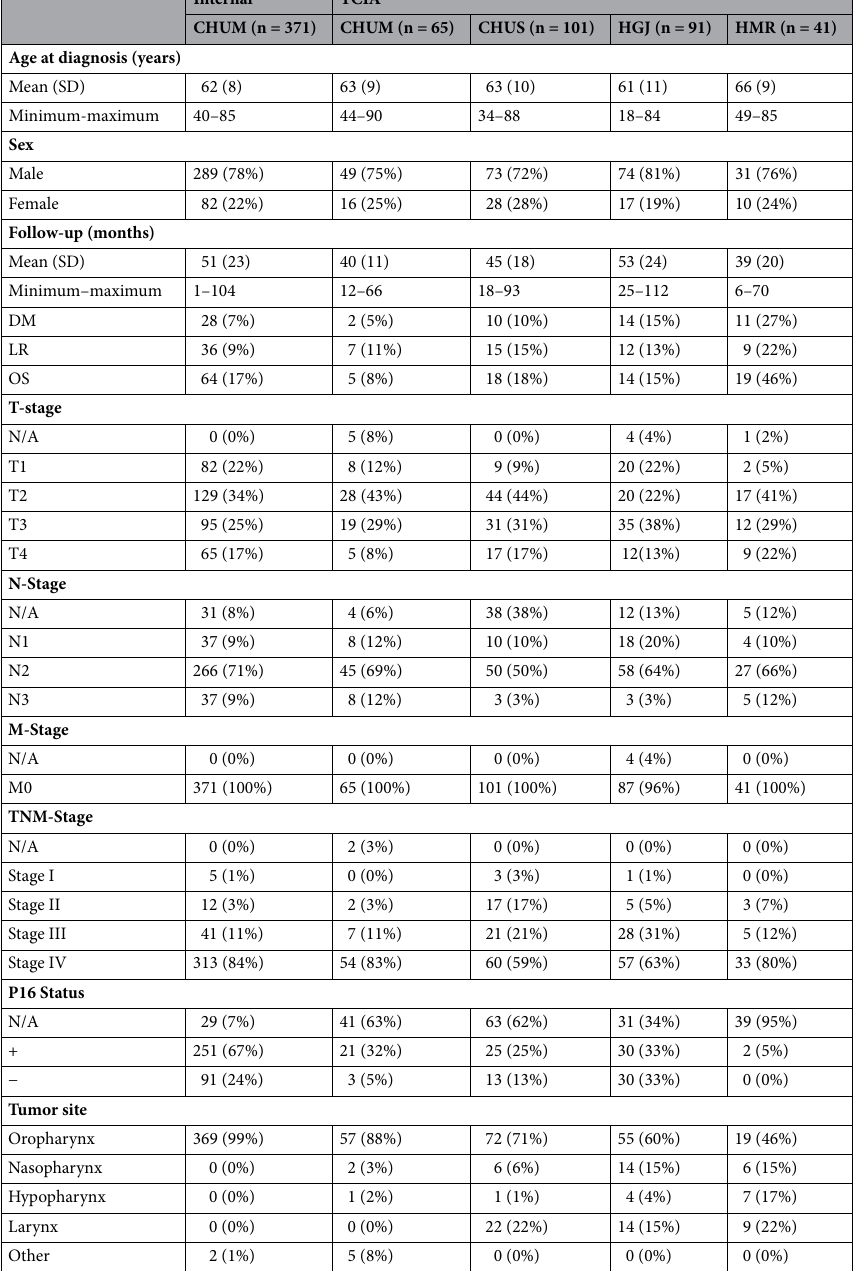
Table 1. Characteristics of patient cohorts with H&N cancer for 4 institutions acquired from the Cancer Imaging Archive (TCIA) and internally at the CHUM. Figures are mean (standard deviation) where indicated,minimum–maximum value where indicated, and number (% of non-missing values) otherwise. The TNM staging system indicates the size and extent of the primary tumor, the number of nearby cancerous lymph nodes and whether the cancer has metastasized at the onset of the study,